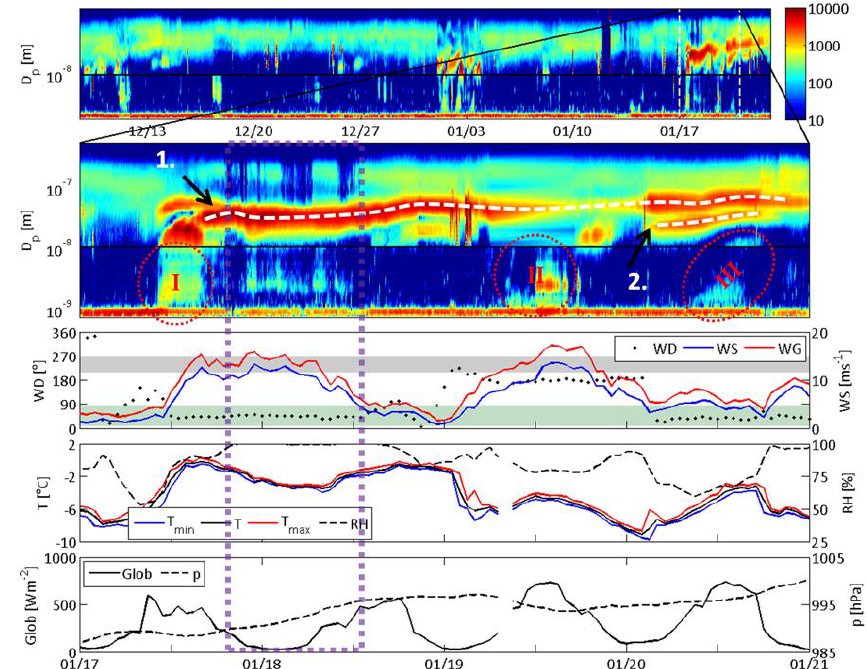
Fig. 4. Same as Fig. 3, except zoomed for the event period 17 to 20 January 2010. The period inside the cloud is marked with a dashed purple rectangle. Figure 4 Same as Fig. 3, except zoomed for the event period 17 to 20 January 2010. The 3 period inside the cloud is marked with dashed purple rectangle. 4